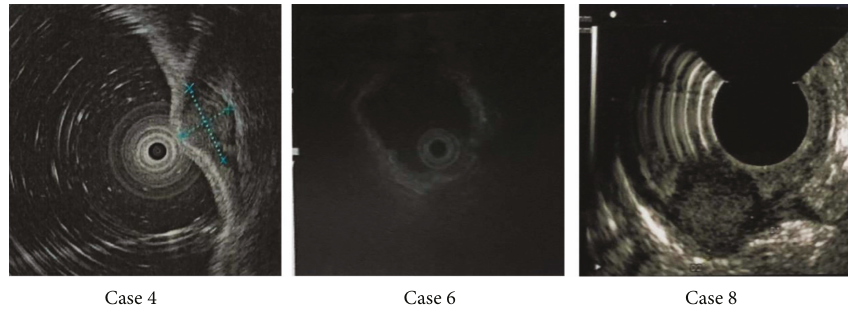
Figure 4: EUS showing submucosal masses mainly located in the submucosa and muscularis propria. Table 2: Preoperative examination fi ndings of patients with intestinal schwannoma.